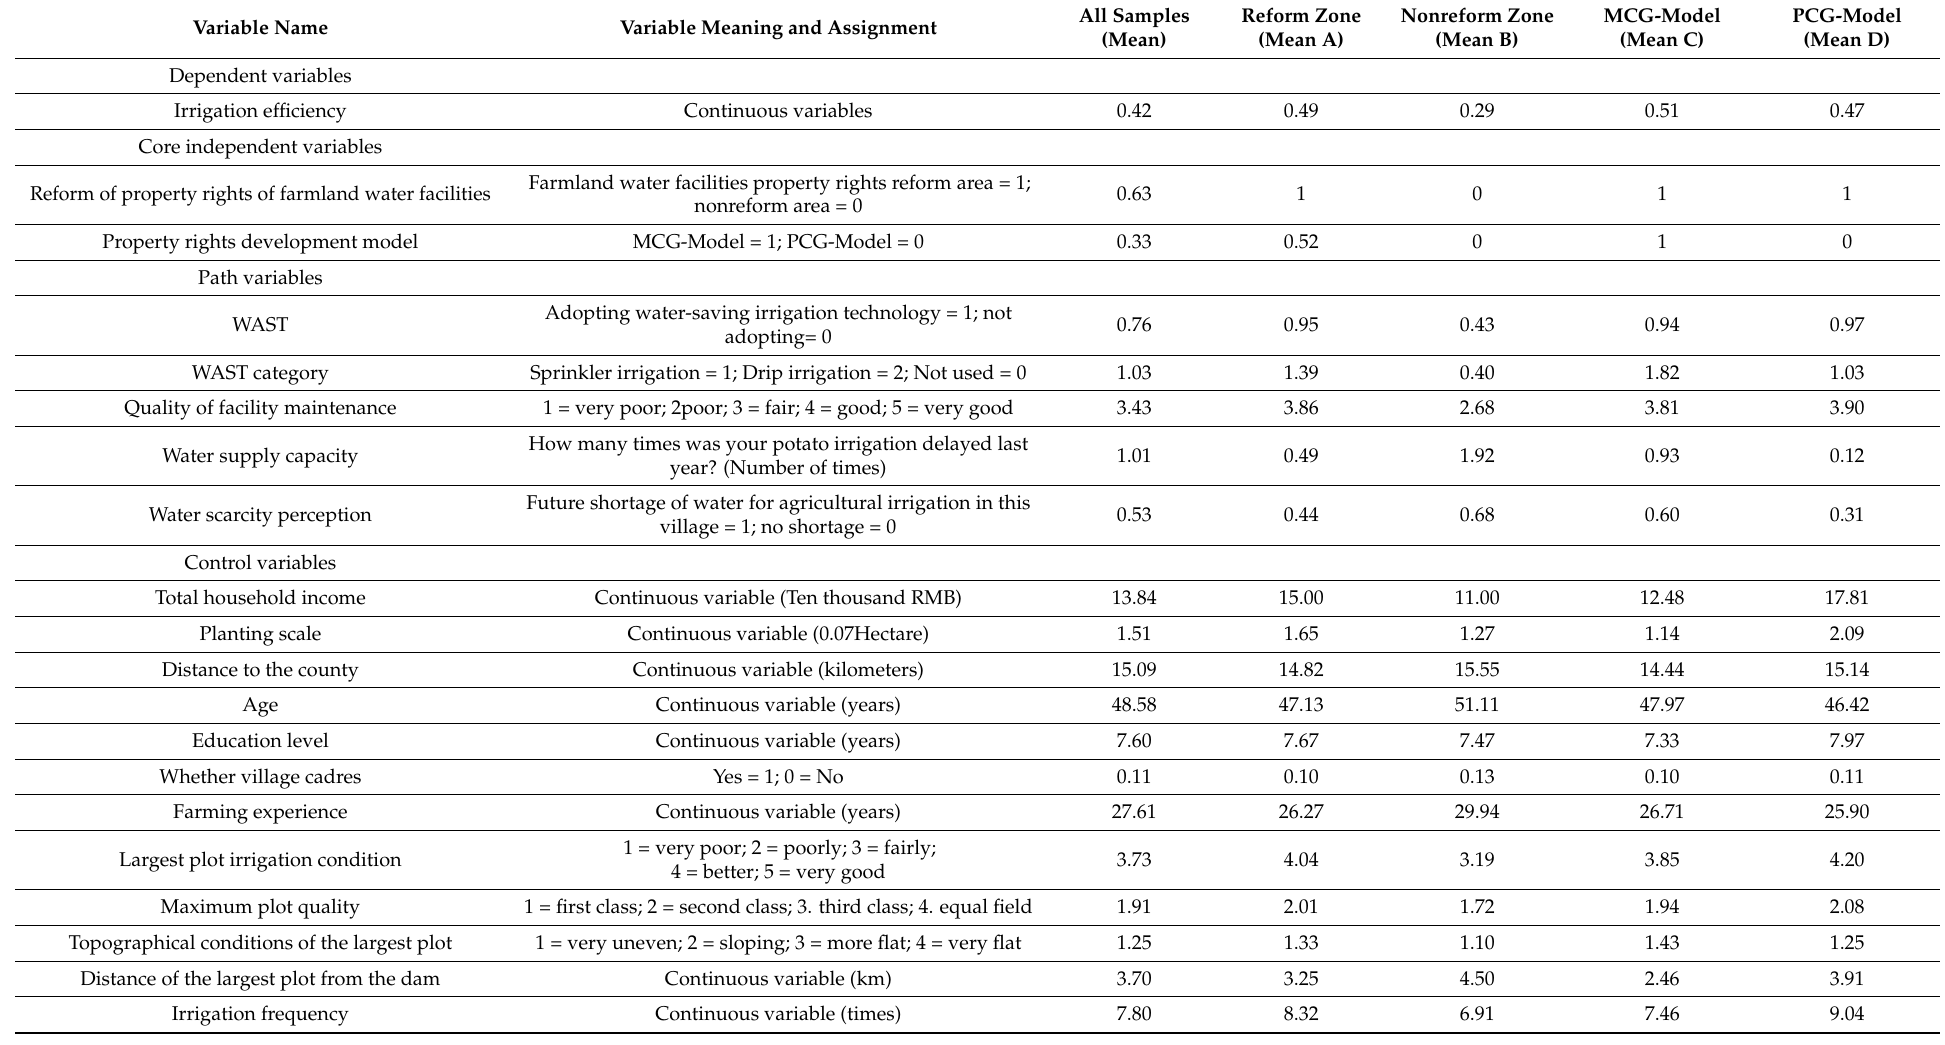
Table 3. Descriptive statistics of